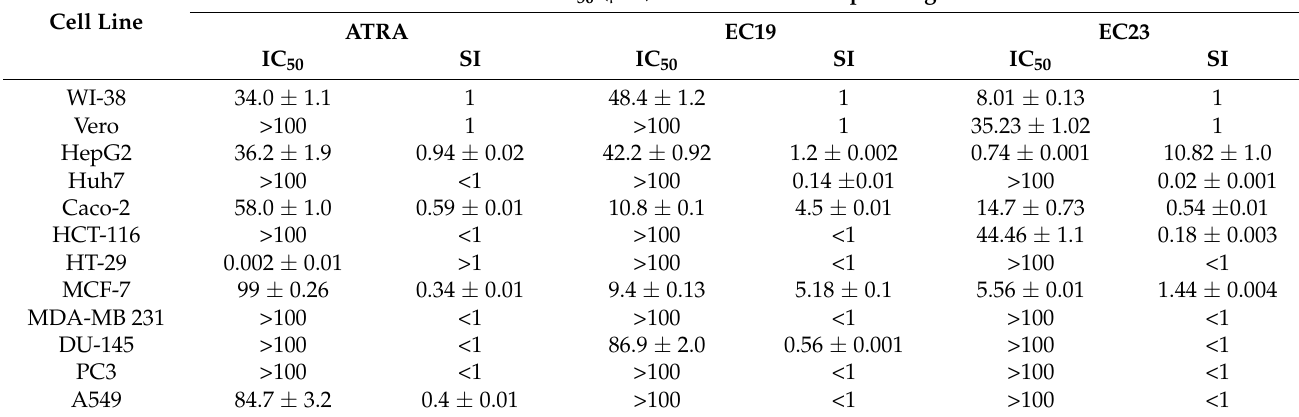
Table 1. The In Vitro antiproliferative activity of all- trans -retinoic acid (ATRA), EC19 and EC23 against different cancerous cell lines. WI-38 was selected as a normal cell line from human origin for the calculation of SI (selectivity index). SI was calculated as IC 50 retinoid (WI-38)/IC 50 retinoid (cancer cell line). Data represent mean ± standard error of the mean (SEM), n = 3.